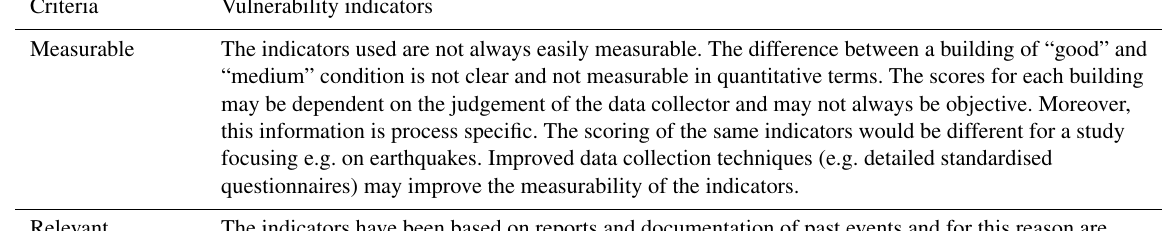
Table 3. Quality criteria for vulnerability indicators (adapted from Birkmann, 2006).